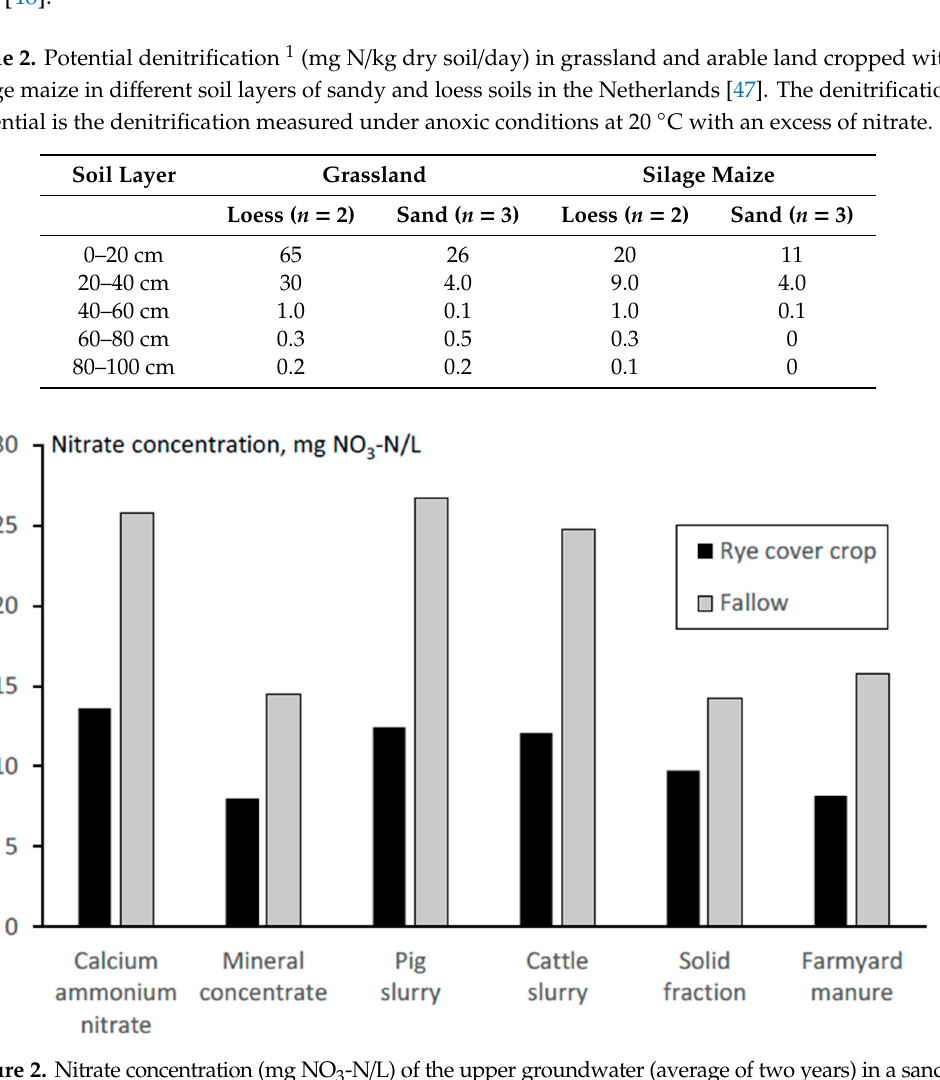
Figure 2. Nitrate concentration (mg NO 3 -N / L) of the upper groundwater (average of two years) in a sandy soil cropped with maize as related to the N source and winter cover crop. N was applied at 150 kg N / ha [37].